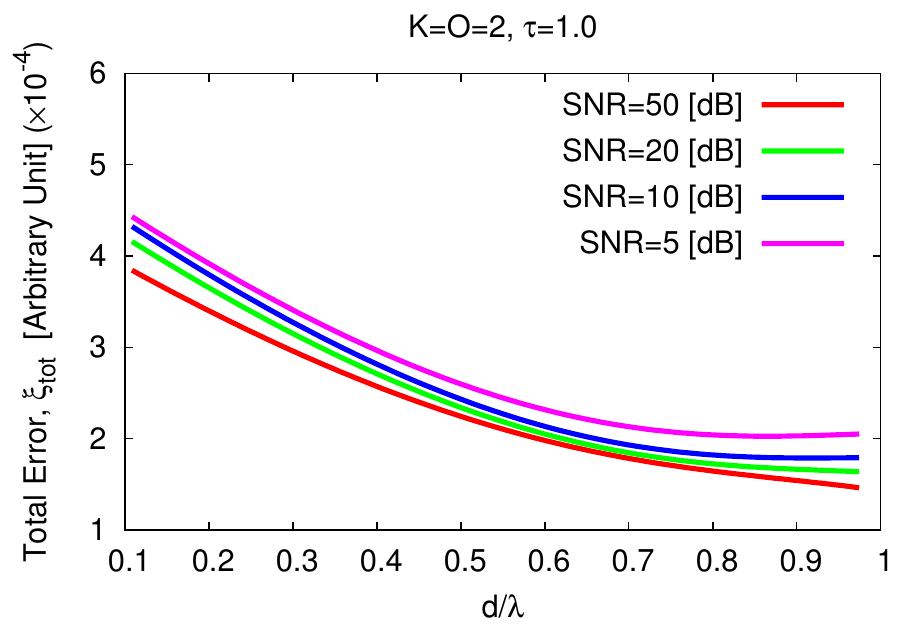
Figure 9. Numerical Assessment ( K = 2, O = 2, τ = 1.0, SNR ∈ [ 5, 50 ] [dB])—Behavior of the total error, ξ tot , versus the distance of the scatterers from the origin, d